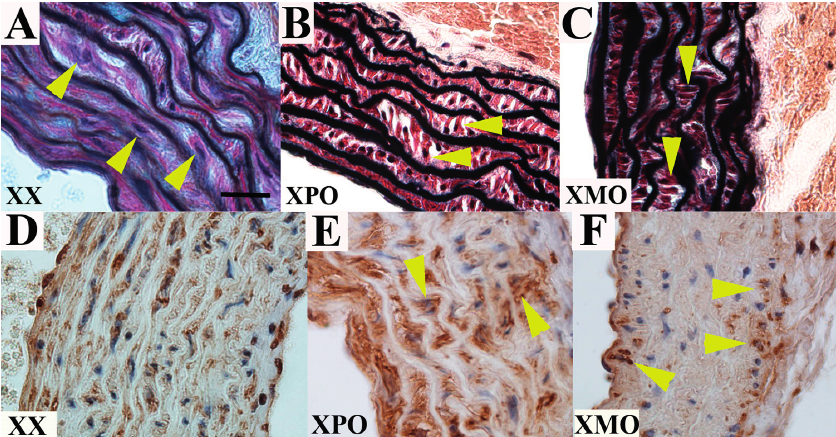
Figure 2. Aorta smooth muscle cell orientation is abnormal in both 39,X M O and 39,X P O mice, but content is decreased in 39,X M O mice only. High magnification of the ascending aorta in adult 40,XX wild type controls ( A ) 39,X P O ( B ) and 39,X M O ( C ) mice demonstrate intact elastic fiber architecture and subtle smooth muscle cell misalignment abnormalities in both 39,X P O and 39,X M O mice. Note the plane of the smooth muscle cells in the 39, XO mice (yellow arrowheads) is orthogonal to the plane of elastic fibers, when compared with the normal parallel orientation of the cells (yellow arrowheads in panel H). SMA staining shows normal diffuse expression in 40,XX ( D ) aortas, as well as 39,X P O ( E ) aortas despite the cell orientation abnormality, but significantly decreased expression in 39,X M O mice ( F ). Panels are shown at 100×; scale bar 25 μ